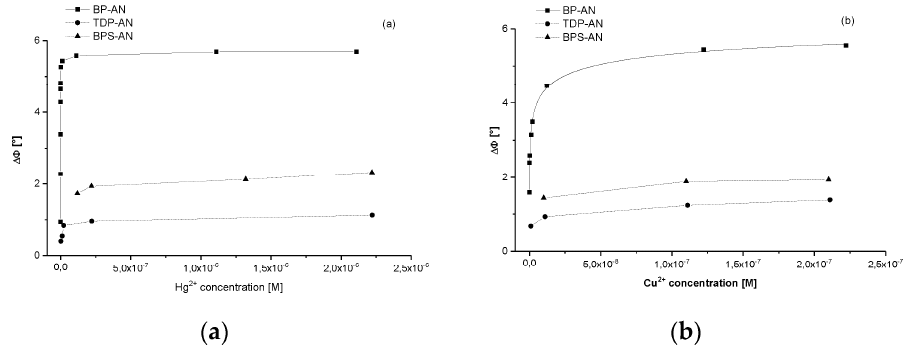
Figure 1. Phase-shift variations ( ΔΦ ) for BP-AN, TDP-AN and BPS-AN derivatives versus. ( a ) Hg 2+ concentration ( b ) Cu 2+ concentration.